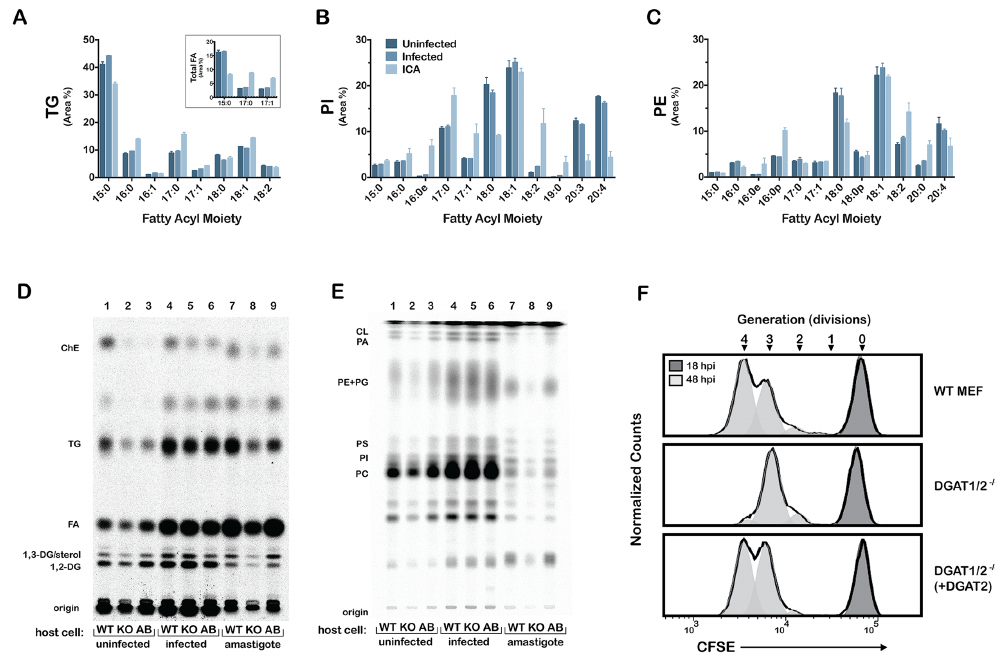
Fig 6. T . cruzi intracellular amastigotes (ICA) scavenge and incorporate exogenous FA, amastigote FA acquisition and proliferation are compromised in DGAT-TG synthesis deficient host cells. Lipidomic analysis of uninfected HFF ( uninfected ), T . cruzi -infected HFF (infected ) and T . cruzi amastigotes purified from HFF ( ICA ) show incorporation of exogenous C15:0 FA into (A) TG, (A, inset) total FA, dotted line indicates the average C15:0, C17:0, C17:1 in unlabeled samples, (B) PI, and (C) PE. Representative autoradiographs showing (D) neutral lipid and (E) glycerophospholipid TLC analysis of 14 C-palmitate incorporation into uninfected (lanes 1–3), infected (lanes 4–6), and isolated amastigotes (lanes 7–9) from wild type mouse embryonic fibroblasts, diacylglycerol acyl transferase 1/2 knockout MEF DGAT1/2 -/- , and DGAT1/2 -/- (+DGAT2) cell lines, respectively; (F) Proliferation of T . cruzi amastigotes measured by CFSE intensity at 18 hpi (undivided) and 48 hpi in WT MEF, DGAT1/2 -/- and DGAT1/2 -/- (+DGAT2) cell lines.